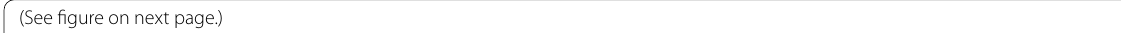
Fig. 4 Microstructures in garnet-bearing gneiss (ZR4). a Grt1 and Jd1 porphyroclasts wrapped by the S2 mylonitic foliation marked by Wm3 and Ep2. Note Grt2 corona rimming Grt1. Plane polarized light. Long side of the microphotograph 3.3 mm. b Back-Scattered Electron (BSE) image = that shows Grt1 and Wm1 porphyroclasts rimmed by Grt2 corona and Wm2, respectively. The S2 mylonitic foliation is marked by Ep2 and Wm3 and wraps the porphyroclasts. c Porphyroclasts of Grt1 and Jd1 wrapped by the S2 foliation marked by Wm3, Grt2 and Ep2. Plane polarized light. Long side of the microphotograph 0.86 mm. d Back-Scattered Electron (BSE) image of photograph c. Grt1 is rimmed by Grt2 corona and Wm2 = grows within Grt1 fractures. Jd1 and Grt1 porphyroclasts are rotated and wrapped by the S2 foliation, which is marked by Wm3, Ep, Grt2 and rare Gln1. e The S2 mylonitic foliation is marked by Wm3, Ep2 and Qz layers. Jd1 occurs as porphyroclasts and within folded layers with unrooted fold hinges and axial plane (AP1) parallel to the S2 foliation. Plane polarized light. Long side of the microphotograph 3.3 mm. f Back-Scattered Electron = (BSE) of the area located by the white square in panel e, after 90-degree anti-clockwise rotation. The folded level consists of small Jd1 crystals. The S2 foliation is marked by Wm3, Ep2 and Qz. g Large Grt1 porphyroclast with Gln1 fibers growing within boudin necks of Grt1, parallel to the S2 direction. Plane polarized light. Long side of the microphotograph 3.3 mm. h Grt1, Grt2 and Gln1 fibers parallel to the S2 direction. Plane polarized = light. Long side of the microphotograph =